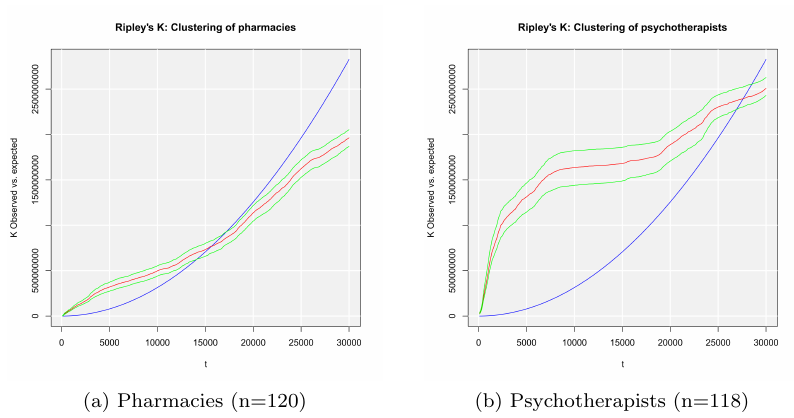
Figure 4: Plots of the Ripley-K function with confidence